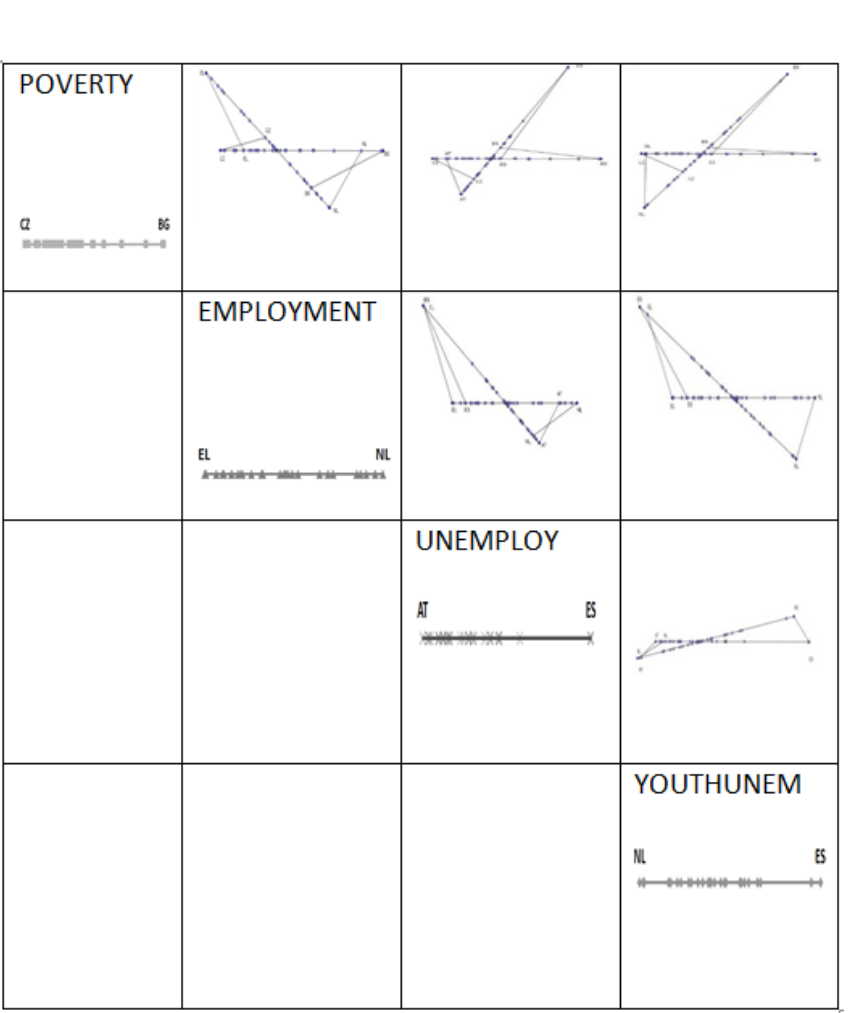
Figure 3 – The swallow-tail plot matrix of the four